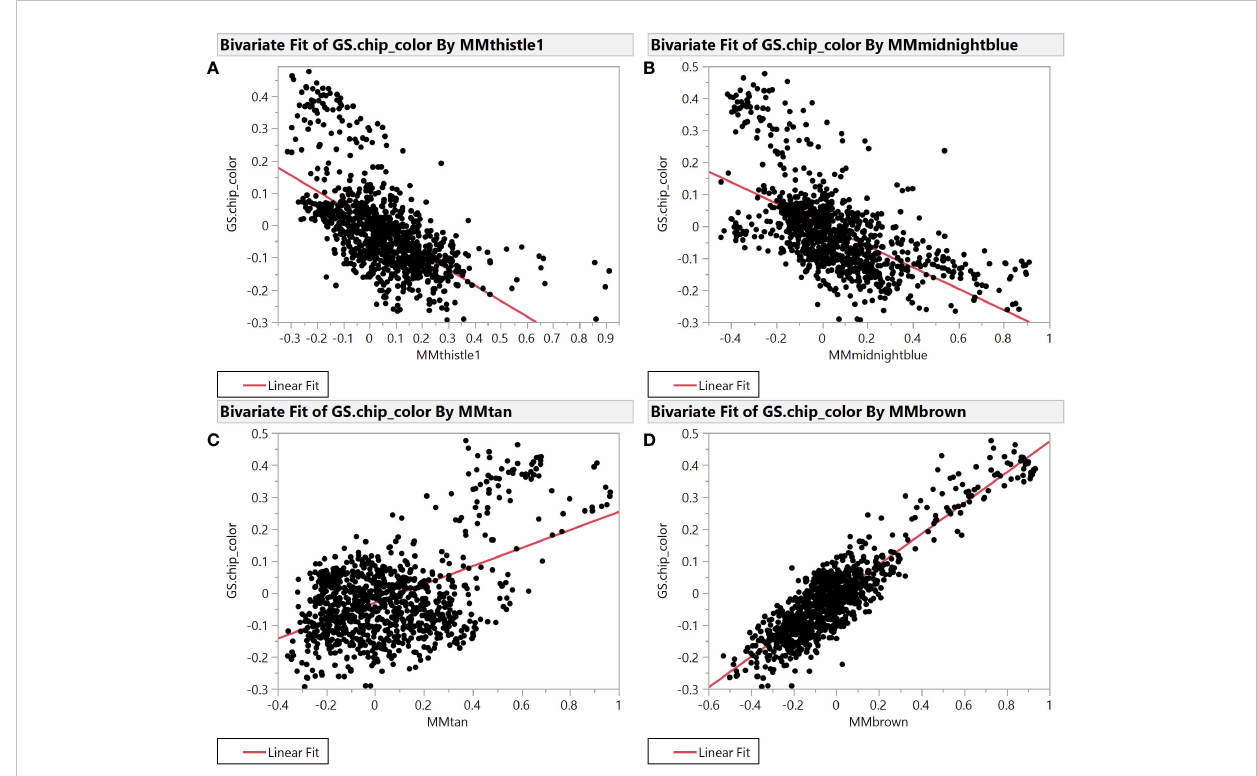
FIGURE 2 Module Membership vs. Gene Trait Signi fi cance for average chip color evaluated in New York. The four plots illustrate the relationship between module membership in four representative modules and gene trait signi fi cance scores for chip color. Module membership (MM) in thistle1 (A) , midnightblue (B) , brown (C) , and tan (D) versus gene trait signi fi cance (GS) for average chip color in the SolCAP